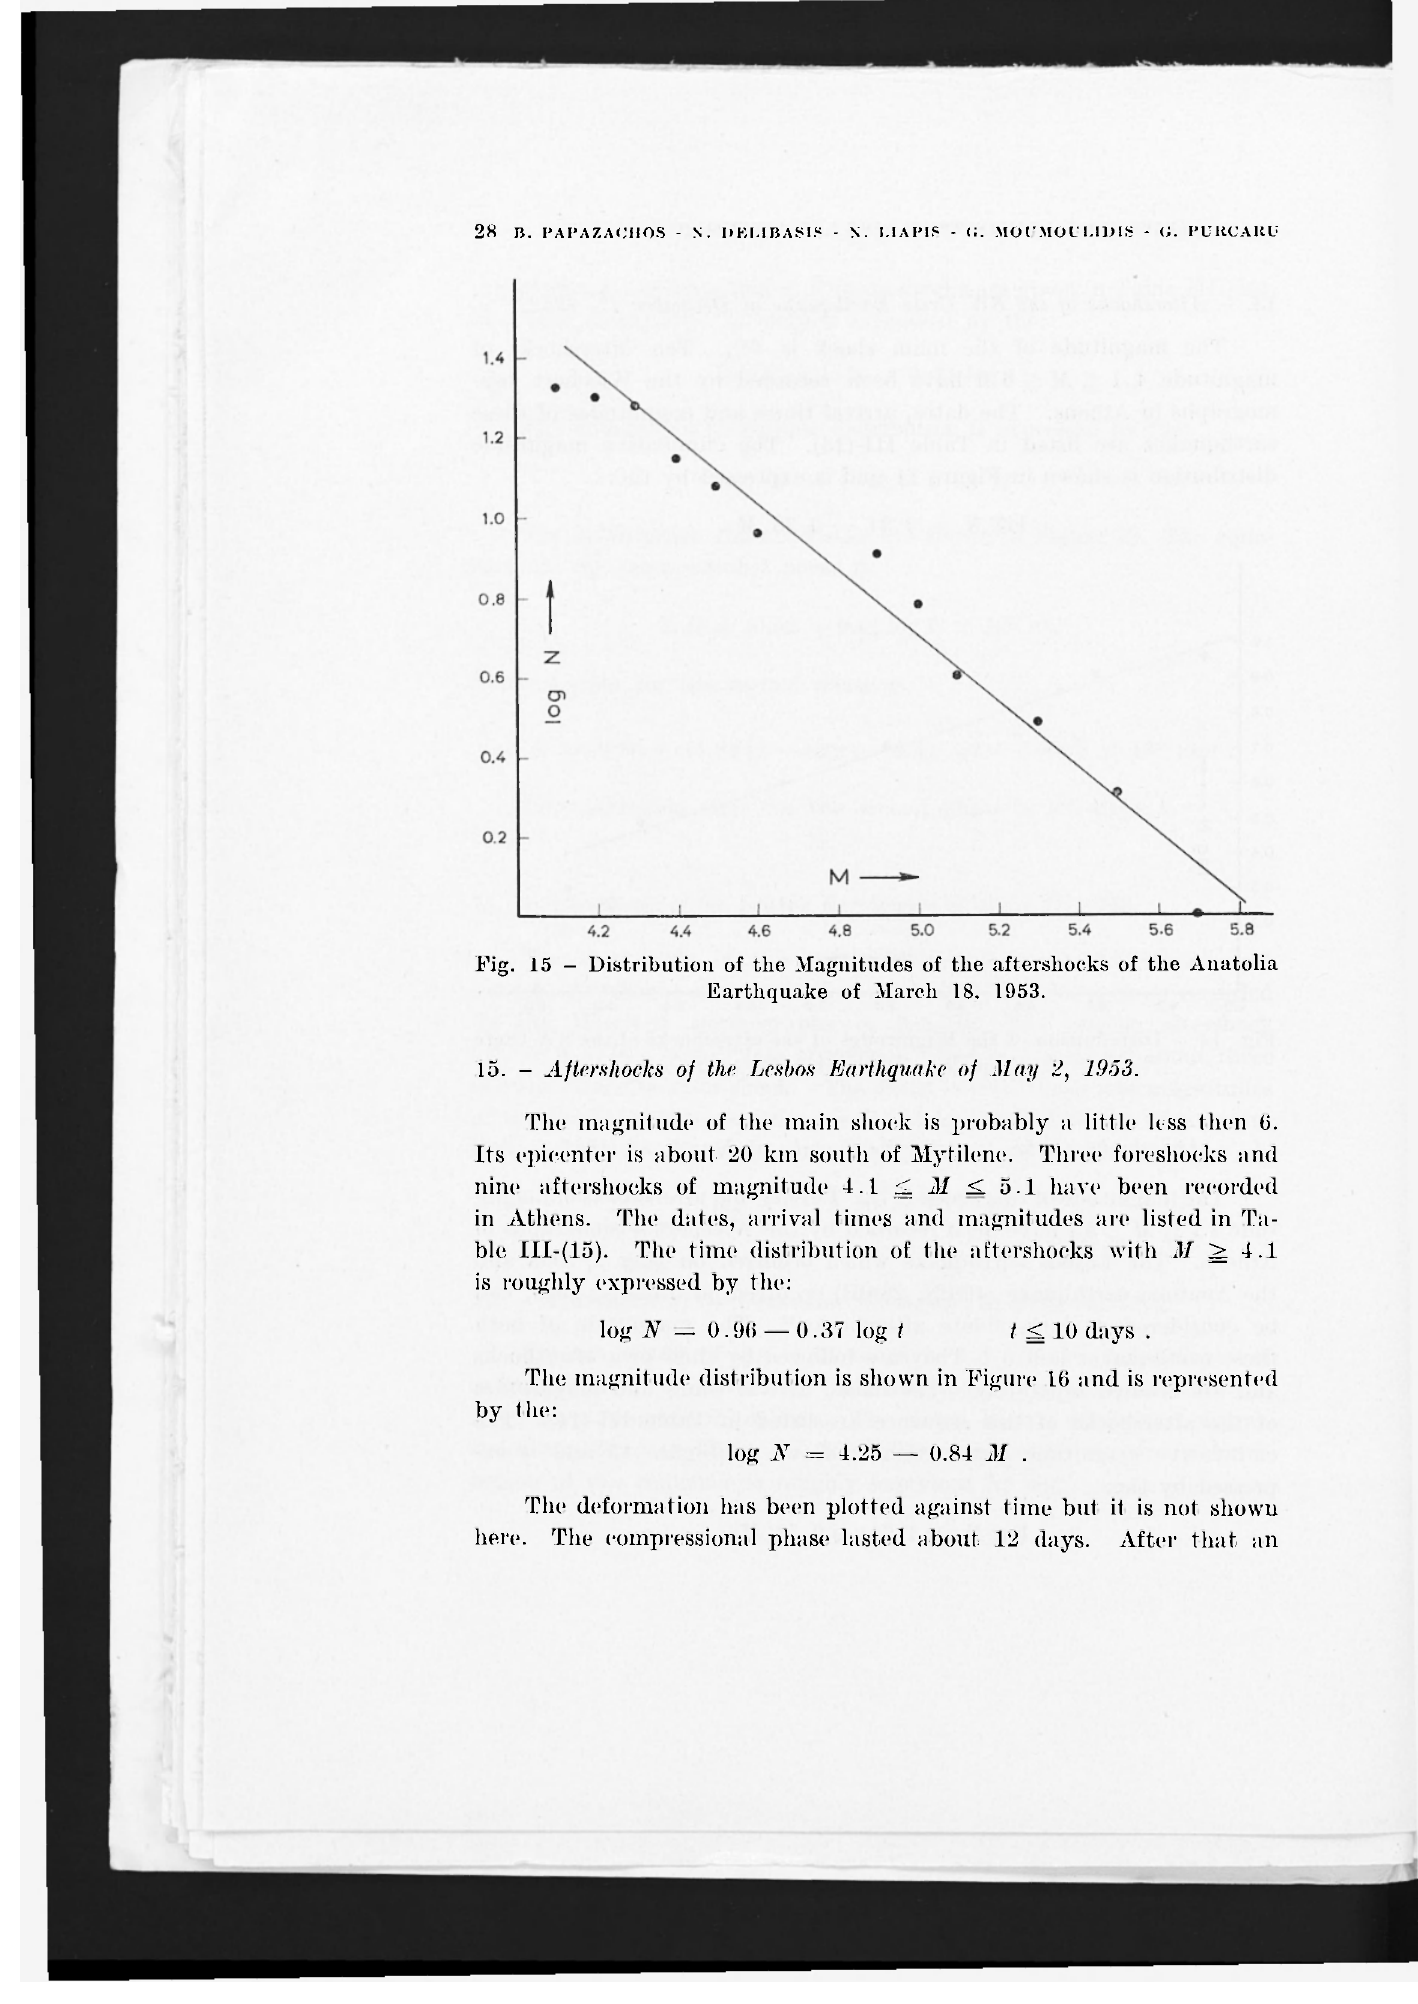
Fig. 15 - Distribution of the Magnitudes of the aftershocks of the Anatolia Earthquake of March 18.